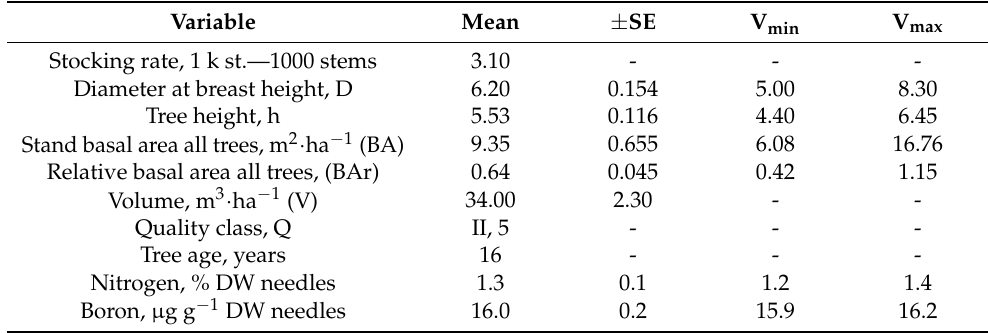
Table 1. Descriptive statistics of the main forest inventory variables of the site of study and the content of nitrogen and boron in the needles of the year before exposure (May